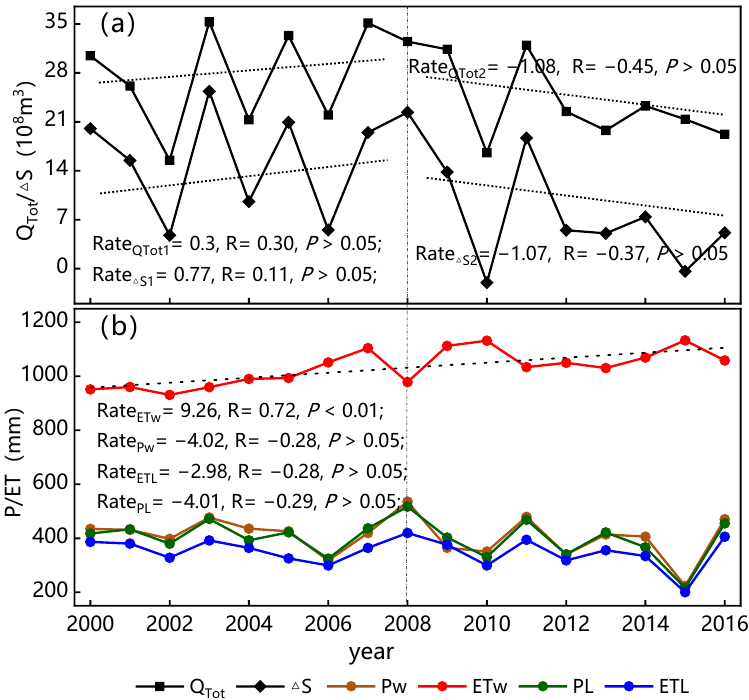
Figure 7. The interannual variation of the ( a ) total lake inflow (Q Tot ), lake water storage capacity ( ∆ S) and ( b ) precipitation (P L or P W ), evaporation (ET L or ET W ) during the simulated period. The water balance showed that lake surface precipitation/evaporation and lake inflow were the main factors affecting changes in lake water storage capacity. The diagram showing correlations of ∆ S with Q, P, and ET was plotted based on the monthly data (Figure 8). Lake inflow, P, and E L were most strongly correlated with ∆ S (R 2 values were 0.80, 0.63, and 0.68, respectively), and there was no obvious correlation between E w and ∆ S, which indicated that lake inflow exerted the most significant impact on ∆ S, followed by P, and the impact of E W was not significant. Analysis showed that E W has a continuous water supply, with small interannual fluctuations, and can be used as a stable indicator of output of water resources from the basin.